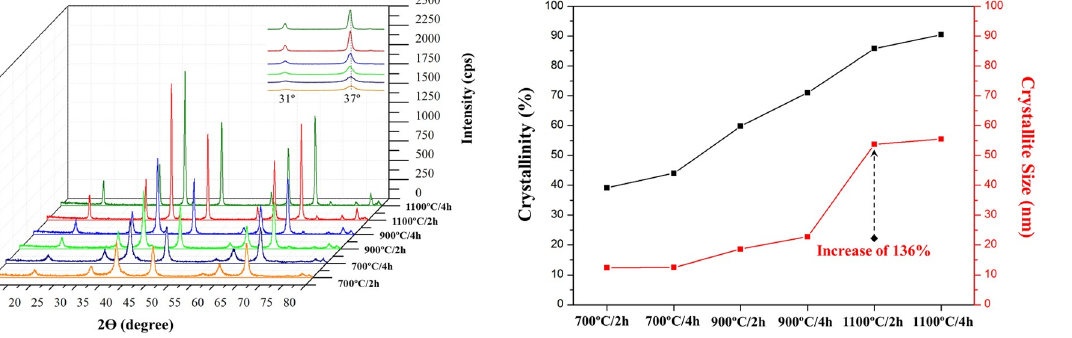
and crystallite